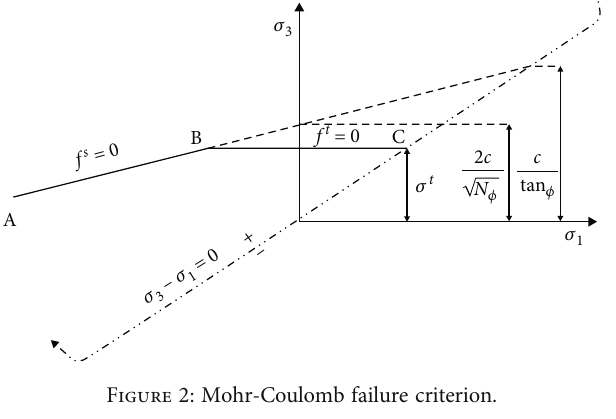
Figure 2: Mohr-Coulomb failure criterion.